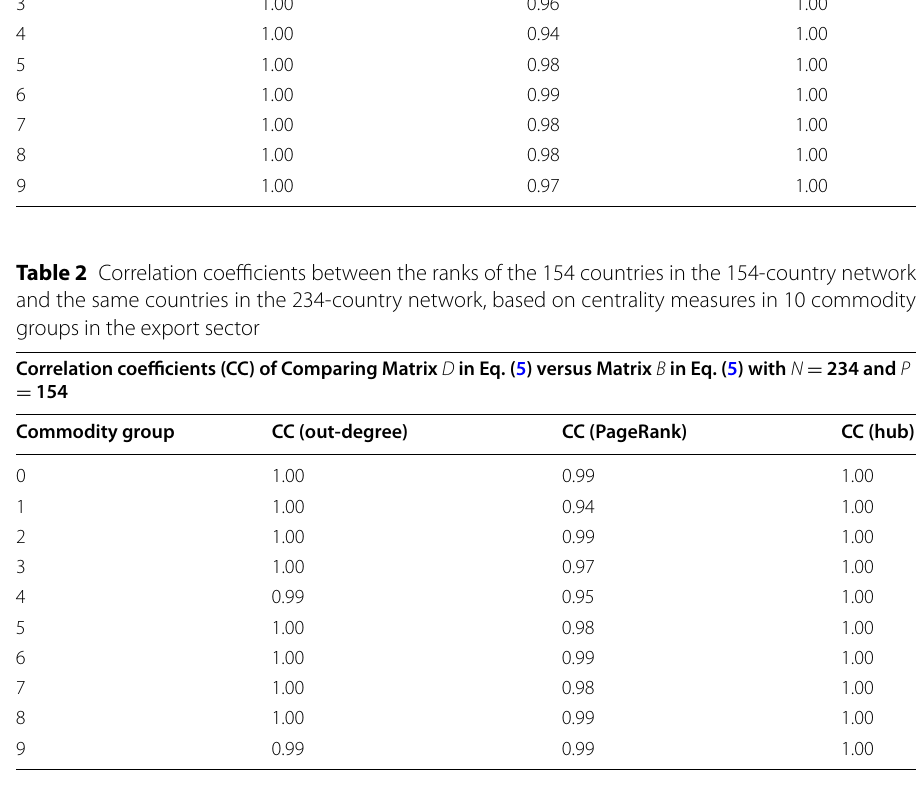
Table 1 Correlation coefficients between the ranks of the 154 countries in the 154-country network and the same countries in the 234-country network, based on centrality measures in 10 commodity groups in the import sector Correlation coefficients (CC) of Comparing Matrix D in Eq. (5) versus Matrix B in Eq. (5) with N P 154. =